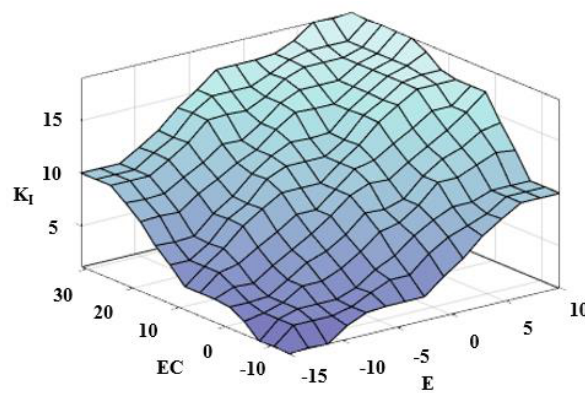
Figure 3. Three-dimensional relationship diagram of the control parameter K p .